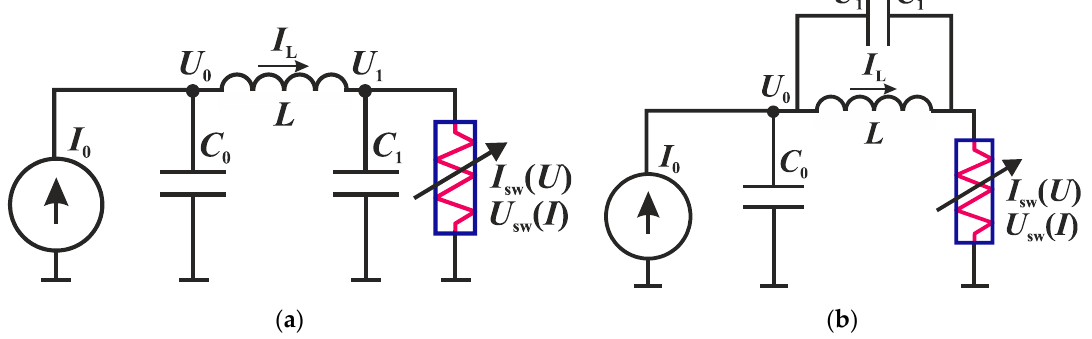
Figure 11. Neural-like circuits based on the S-type switch, generating bursts of oscillation, with a capacitance C 1 connected in parallel to the switching element ( a ) and in parallel to the inductance ( b ). ThecircuitsinFigure11a,baremodeledbythefollowingsystemsofdifferentialequations,